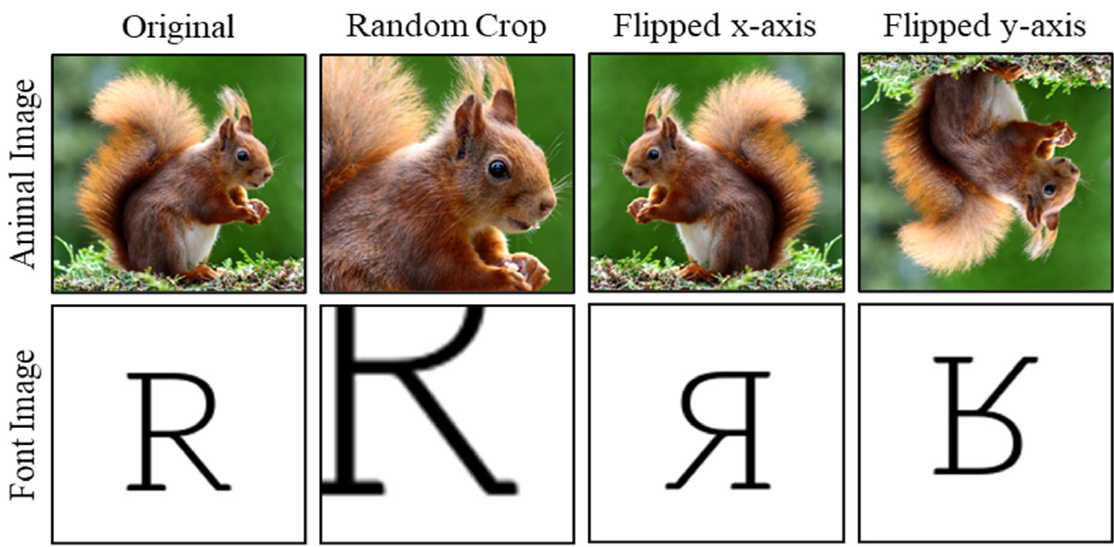
Figure 1. Illustration of the difference between augmenting a real image and a font image.